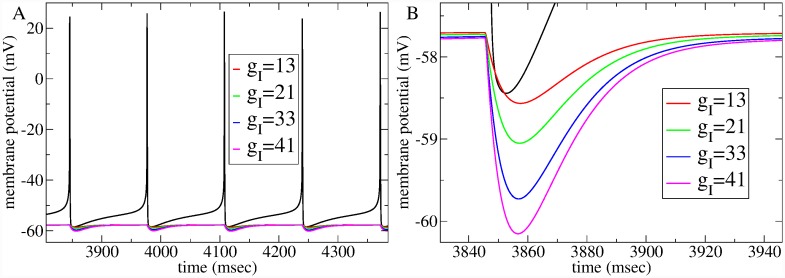
IPSP size and timescale is in the physiological range at values of gI found to provide good fits to WT spiking data.(a,b) Time series of supra-threshold presynaptic spiking cell (black) and slightly sub-threshold postsynaptic cell for different values of gI (see key), (b) shows detail. At gI = 33, IPSP size is about 1.8 mV and reverts to half maximum in about 20 msec.